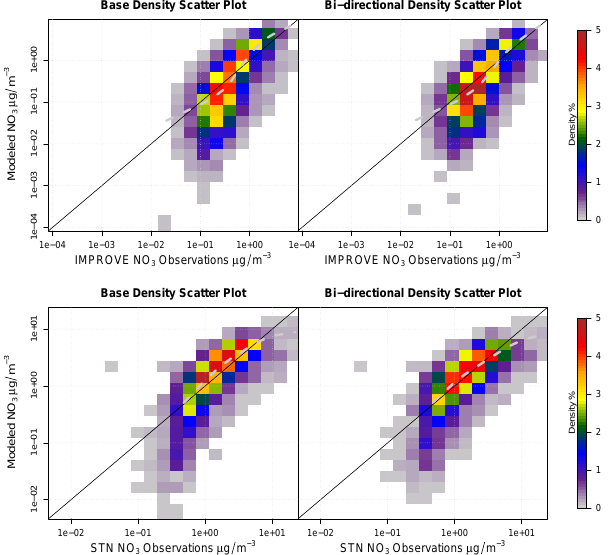
Fig. 5. Density scatter plots of monthly mean NO 3 aerosol observa- tions paired with base and bidirectional CMAQ modeled values at IMPROVE sites, N = 1745 (top panels), and STN sites, N = 2320 (Bottom panels). Annual data were aggregated into 20 bins on a log 10 scale spanning the range of the observations and model re- sults, from 1 × 10 − 4 to 10µgm − 3 for the IMPROVE data and a 5 × 10 − 3 to 25µgm − 3 for the STN data. The dashed line repre- sents a least squares local polynomial regression fit of the model data to the Fig. 4. 2002 annual mean NO − aerosol concentration in the bidirec- 3 tional (top panel) and base case (bottom panel). Mean annual STN observations ( N = 208) are plotted over the map as diamonds and IMPROVE observations ( N = 156) for each measurement site are plotted over the map as circles. Note that the color scale has been plotted on a log axis.